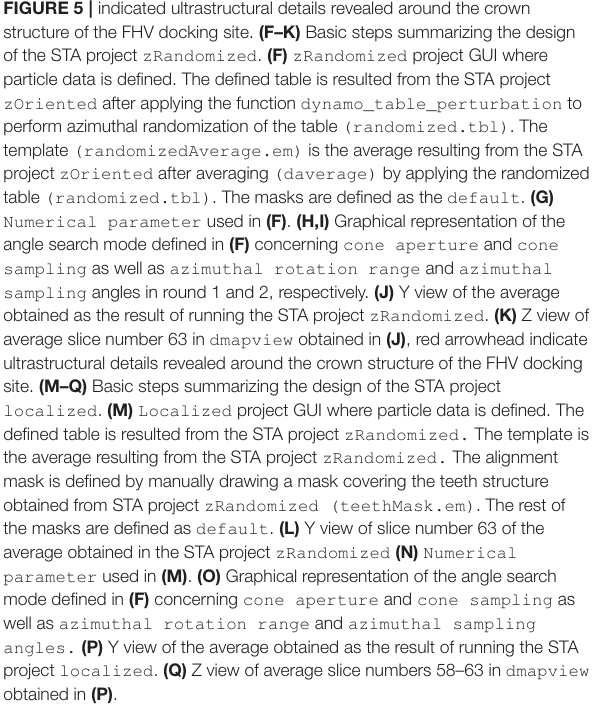
FIGURE 5 | indicated ultrastructural details revealed around the crown structure of the FHV docking site. (F–K) Basic steps summarizing the design of the STA project zRandomized . (F) zRandomized project GUI where particle data is defined. The defined table is resulted from the STA project zOriented after applying the function dynamo_table_perturbation to perform azimuthal randomization of the table (randomized.tbl) . The template (randomizedAverage.em) is the average resulting from the STA project zOriented after averaging (daverage) by applying the randomized table (randomized.tbl) . The masks are defined as the default . (G) Numerical parameter used in (F) . (H,I) Graphical representation of the angle search mode defined in (F) concerning cone aperture and cone sampling as well as azimuthal rotation range and azimuthal sampling angles in round 1 and 2, respectively. (J) Y view of the average obtained as the result of running the STA project zRandomized . (K) Z view of average slice number 63 in dmapview obtained in (J) , red arrowhead indicate ultrastructural details revealed around the crown structure of the FHV docking site. (M–Q) Basic steps summarizing the design of the STA project localized . (M) Localized project GUI where particle data is defined. The defined table is resulted from the STA project zRandomized. The template is the average resulting from the STA project zRandomized. The alignment mask is defined by manually drawing a mask covering the teeth structure obtained from STA project zRandomized (teethMask.em) . The rest of the masks are defined as default . (L) Y view of slice number 63 of the average obtained in the STA project zRandomized (N) Numerical parameter used in (M) . (O) Graphical representation of the angle search mode defined in (F) concerning cone aperture and cone sampling as well as azimuthal rotation range and azimuthal sampling angles. (P) Y view of the average obtained as the result of running the